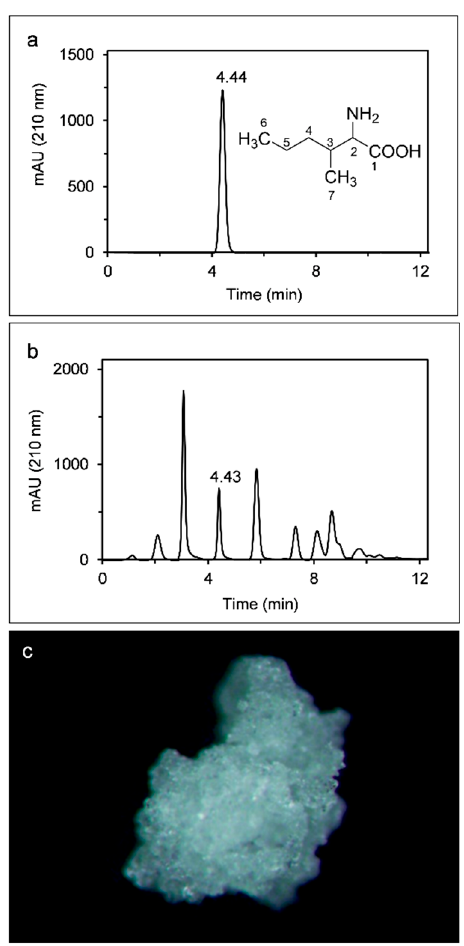
Figure 1. Purification of AMHA isolated from the mycelia of A. alternata . ( a ) MPLC chromatogram of 8 mg L − 1 standard solution of AMHA. ( b ) MPLC chromatogram of extracts from A. alternata . The peak corresponding to AMHA is labelled. ( c ) Crystals of naturally produced AMHA.